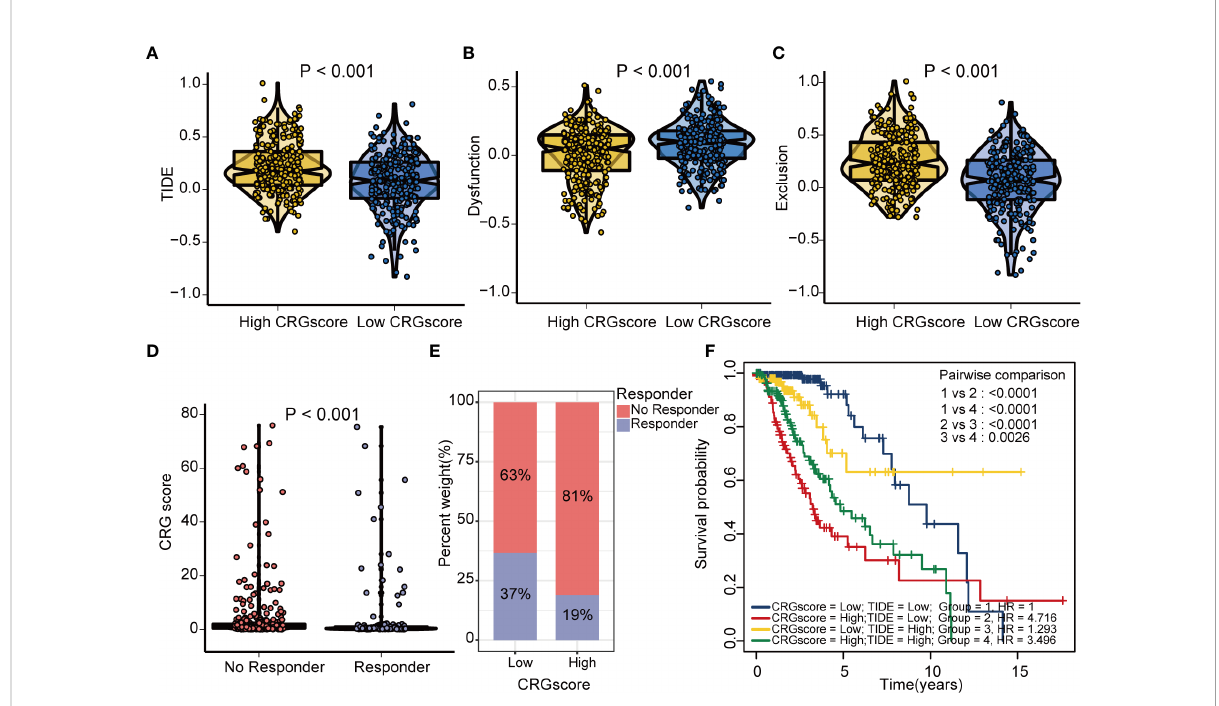
FIGURE 10 Estimation of the cuproptosis-related prognostic model in immunotherapy response in LGG. (A) Difference in TIDE scores between high- and low-risk groups. (B) Difference in dysfunction scores between high- and low-risk groups. (C) Difference in exclusion scores between high- and low-risk groups. (D) Difference in CRG scores between responder and no responder groups based on the TIDE algorithm. (E) The distribution of immunotherapy response in indicated groups strati fi ed by the CRG scores based on the TIDE algorithm. (F) The Kaplan – Meier OS curves among four groups classi fi ed by the CRG score and TIDE score. TIDE, tumor immune dysfunction and exclusion; CRG, cuproptosis-related genes; OS, overall